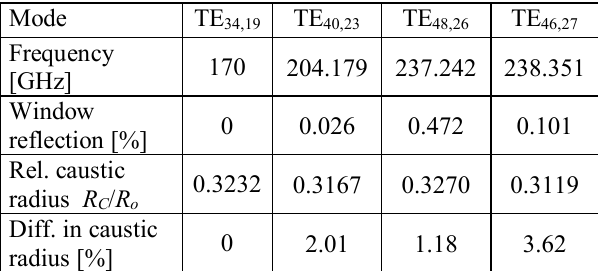
Table 2. Mode Selection for Multi-Frequency